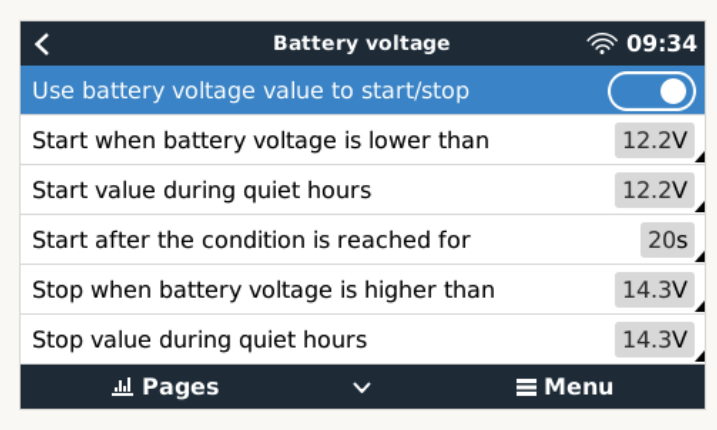
Figure 16. Condition configuration based on voltage.